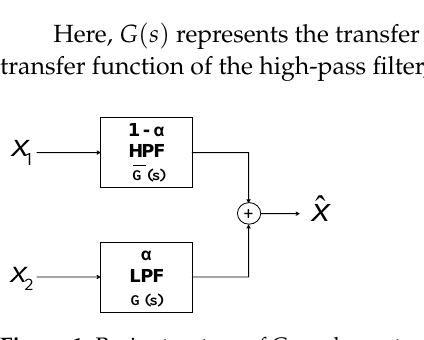
Figure 1. Basic structure of Complementary